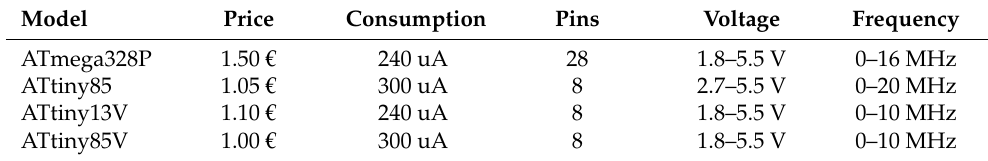
Table 2. Initial list of microcontrollers.